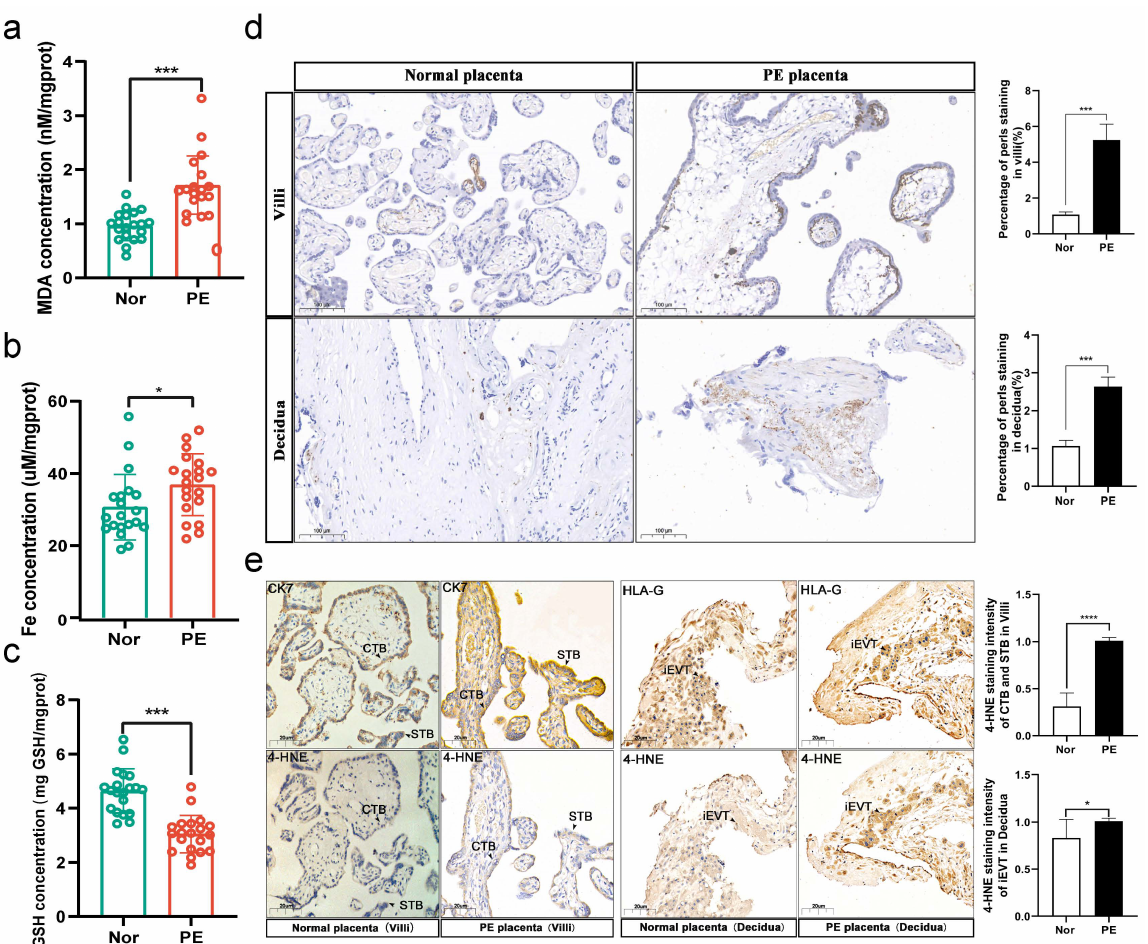
Figure 1. More severe ferroptosis presented in the placentas of PE. Placental tissues were collected from physiologically normal pregnancies ( n = 20) and PE pregnancies ( n = 20). ( a ) MDA concentration, ( b ) iron concentration, and ( c ) GSH concentration were measured using the corresponding detection kits, two-tailed t -test. ( d ) Perls’ Prussian blue staining for iron was performed in human PE and normal placentas. Quantification of staining intensity per patient; n = 3. Scale bars: 100 µ m, two-tailed t -test. ( e ) IHC staining of 4-HNE in human PE and normal placentas. Quantification of staining intensity per patient; n = 3. Scale bars: 20 µ m, two-tailed t -test. iEVTs and CTBs were identified by HLA-G and CK7 staining, respectively. STB, syncytiotrophoblasts; iEVT, interstitial extravillous trophoblast; CTBs, cytotrophoblasts; CK7, cytokeratin 7; HLA-G, human leukocyte antigen G. All data are presented as the means ± SEM. * p < 0.05; *** p < 0.001; **** p <